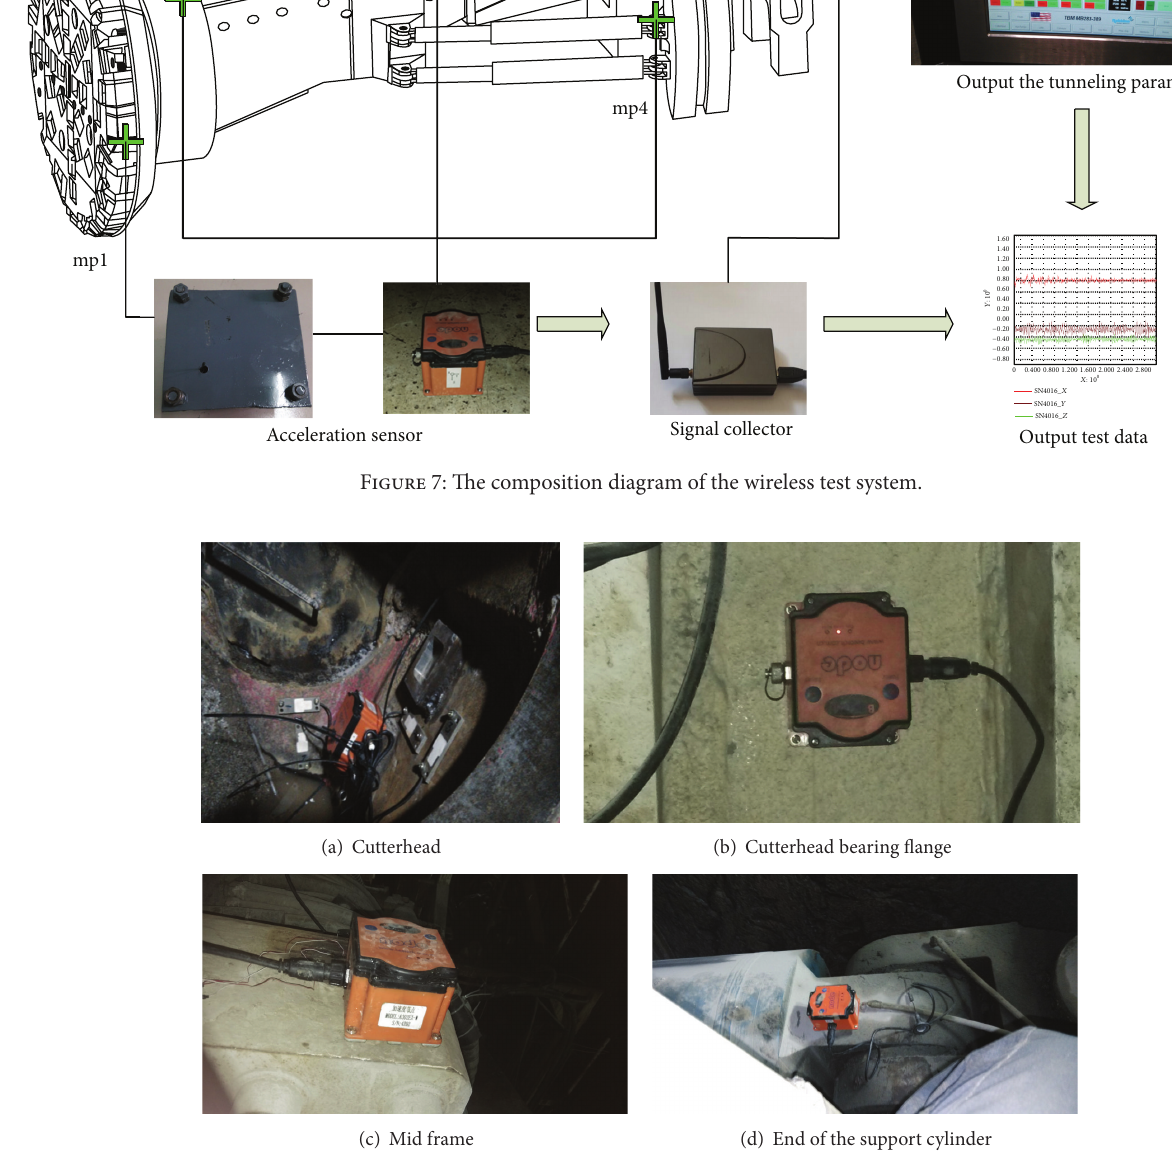
Figure 8: The field test